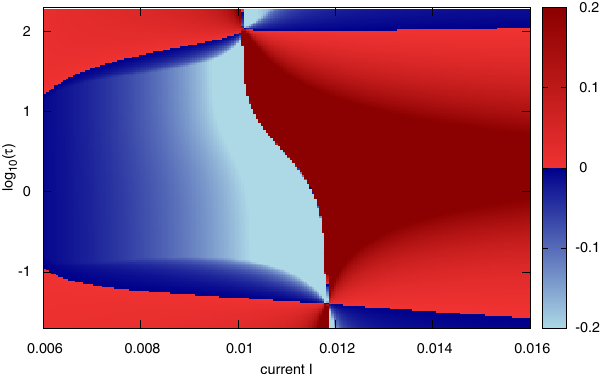
Figure 1. Stability of full synchrony. The evaporation Lyapunov exponent of the fully synchronous periodic state in dependence on the parameters ( I , τ ). This state appears in the supercritical Hopf bifurcation at I H = 0.00315 (see main text), to the left from the shown range of I . Red domains: instability, blue domains: stability. The sharp boundary around I ≈ 0.01–0.012 corresponds to the homoclinic bifurcation of the periodic